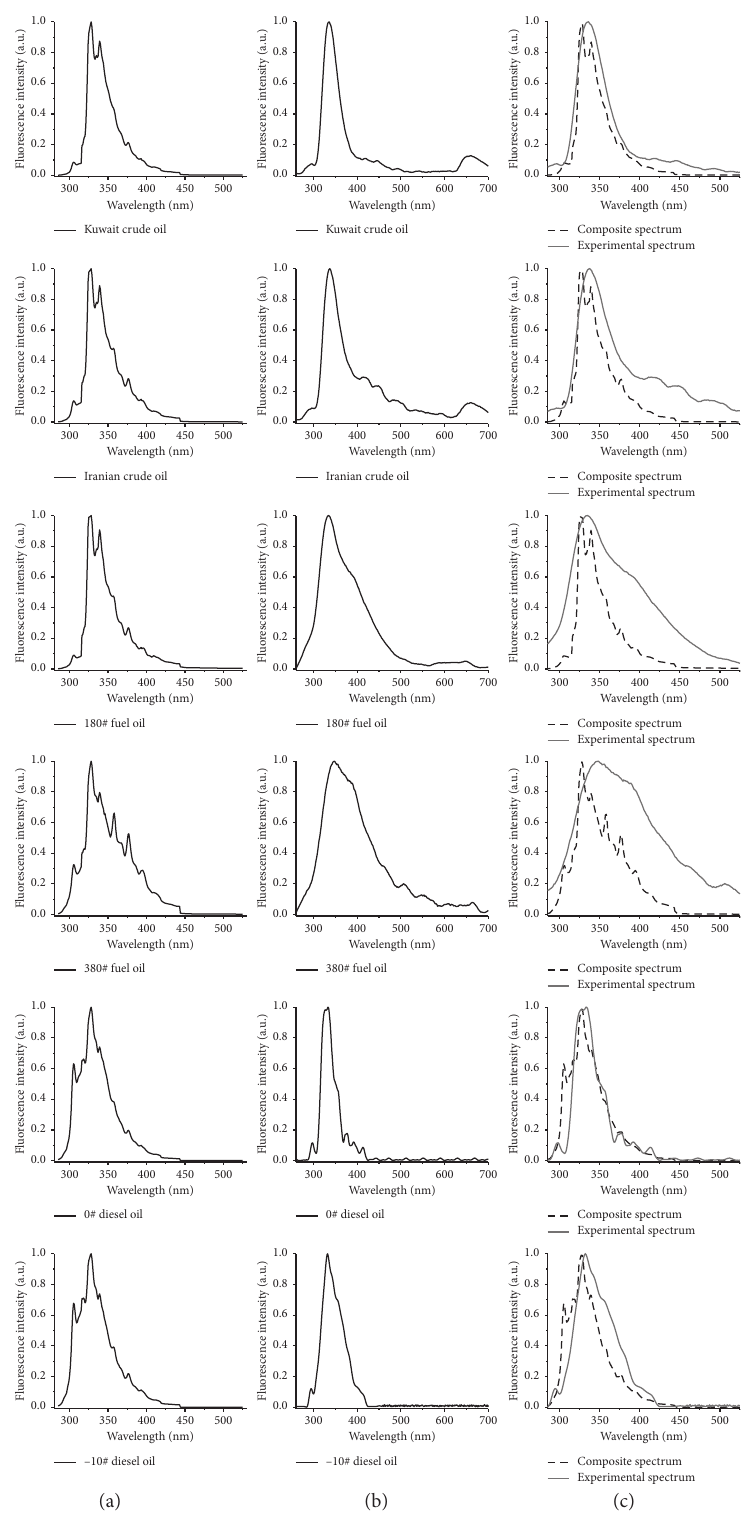
Figure 4: (a) Composite ( X F = E ) and (b) experimental fluorescence spectra (260–700 nm) of Kuwait crude, Iranian crude, 380#, 180# fuel, 0#, and − 10# diesel oil samples. (c) Comparison of the composite and experimental fluorescence spectra of the six oil samples between 285 and